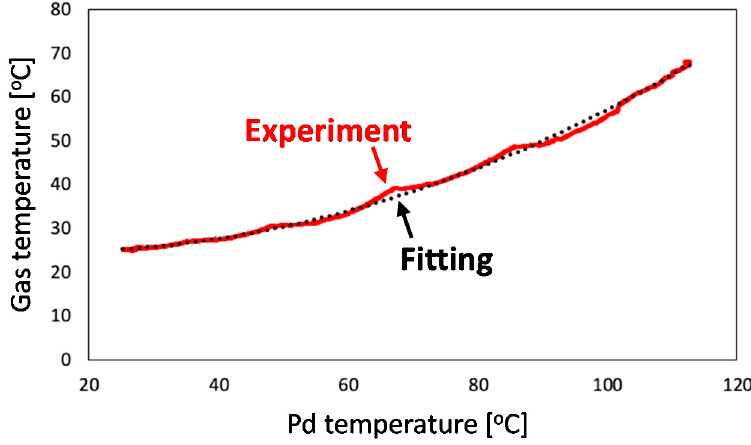
Figure 11. Relationship between Pd and gas phase temperatures.